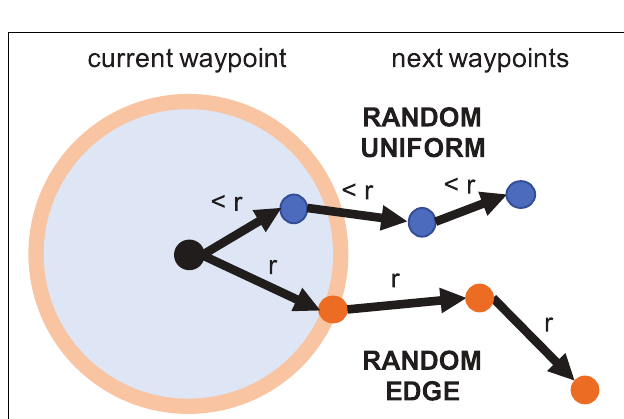
FIGURE 7 | Visualization of the random sampling strategies. Random uniform selects any point inside a local region defined by a fixed radius r . Random edge selects any point along the region’s perimeter, potentially increasing traversed distance and